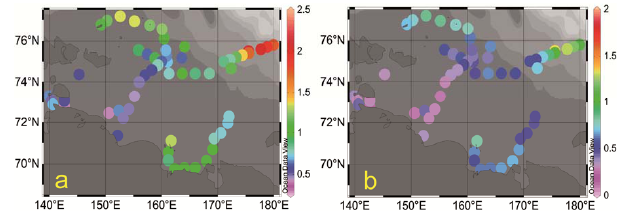
Fig. 11. Distribution of the saturation state of calcite (a) and aragonite (b) in the bottom waters of the ESS, expressed as omega ([Ca 2+ ] [CO 32- ]/K SO ). In both figures saturation is colored green.